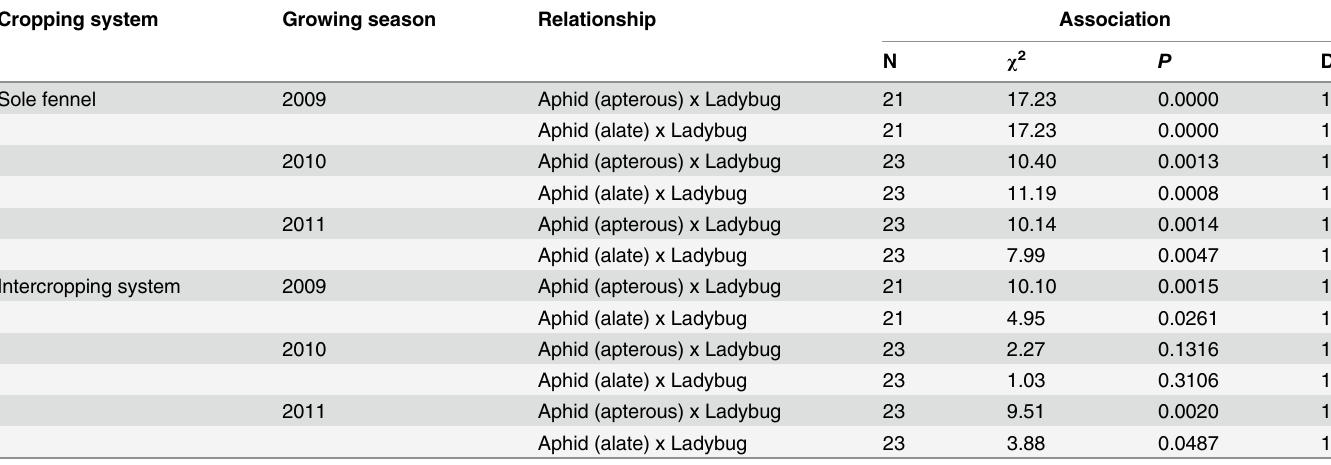
Table 1. Association between C . sanguinea and H . foeniculi (apterous and alate) found in sole fennel and fennel-cotton intercropping systems. Cropping system Growing season